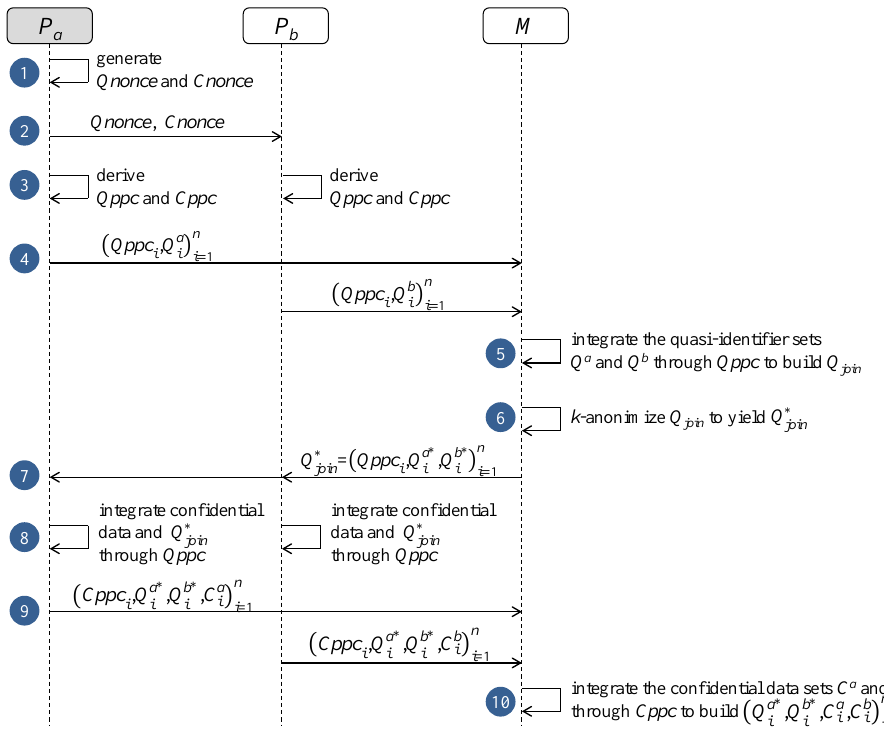
Figure 1. Anonymization and integration protocol in a scenario with two data providers, P a and P b , and a mashup coordinator, M . The provider P a acts as a leading